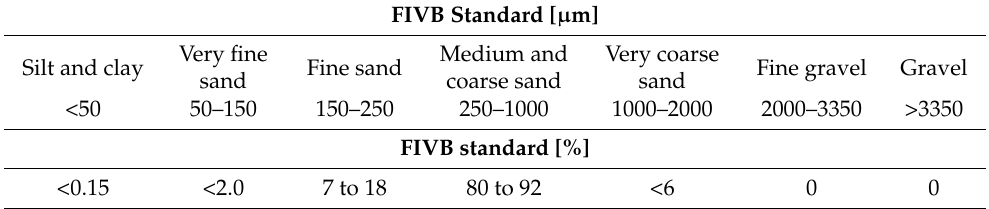
Table 1. FIVB sand